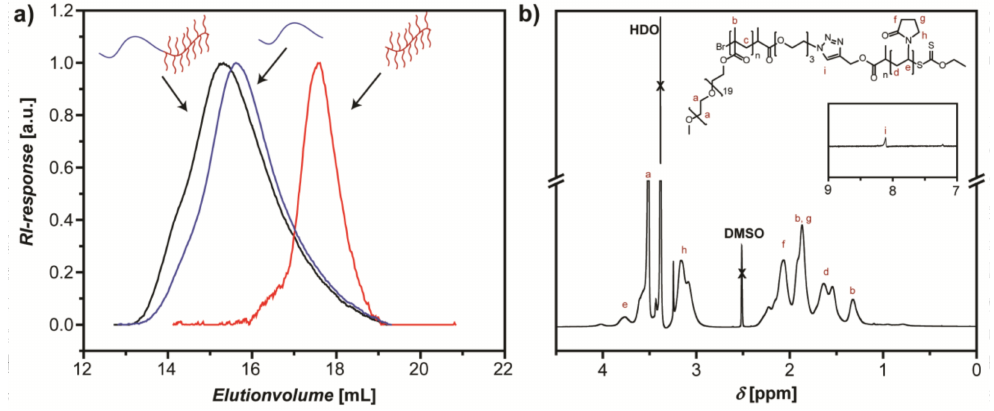
Figure 1. Characterization of PVP 41k - b -POEGMA 22k : ( a ) Size exclusion chromatography (SEC) in NMP at 70 ◦ C (red trace: POEGMA 22k ; blue trace: PVP 41k ; black trace: PVP 41k - b -POEGMA 22k ) and ( b ) 1 H NMR of PVP 41k - b -POEGMA 22k measured in DMSO- d 6 , inset shows the signal for the triazole